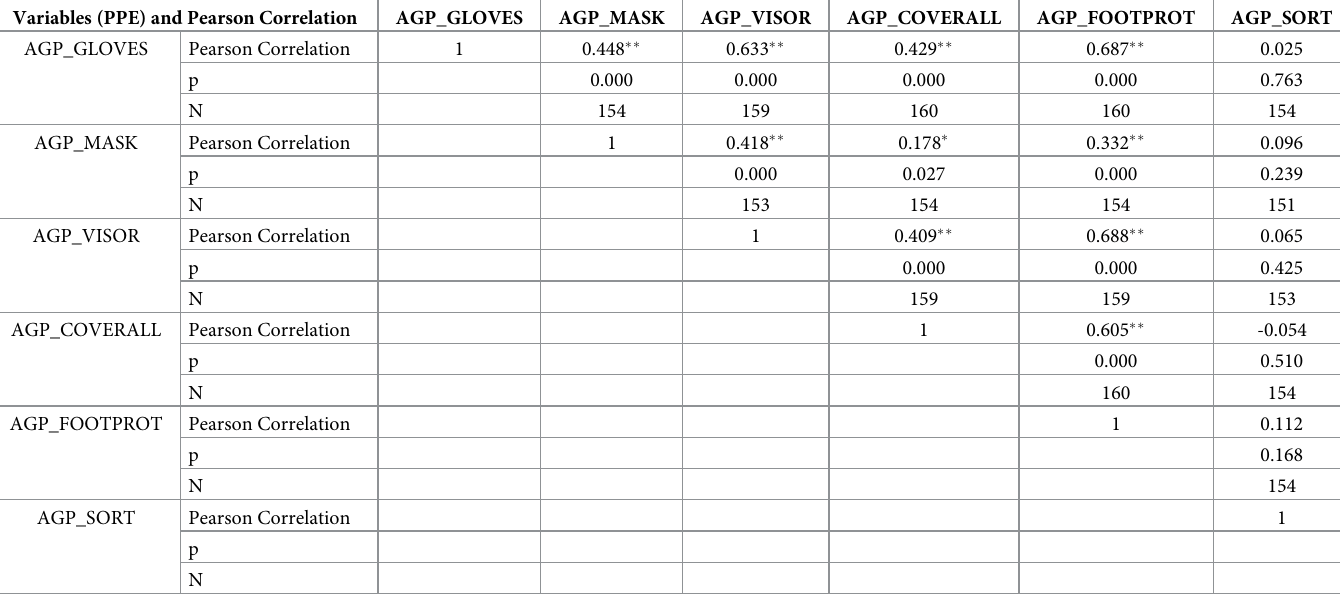
Table 4. Correlation coefficients and associated level of significance. Testing hypotheses H1 and